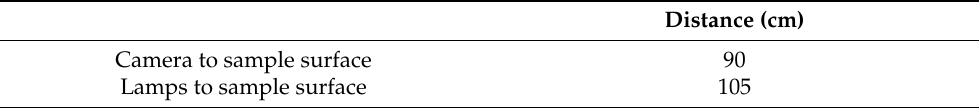
Figure 6. IR image of the canals located in the PET foam core. Table 5. Distances between equipment. Distance (cm) Camera to sample surface 90 Lamps to sample surface